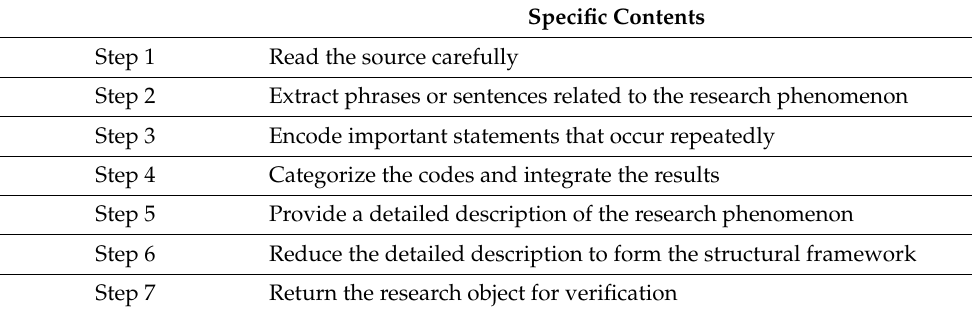
Table 2. Data analysis